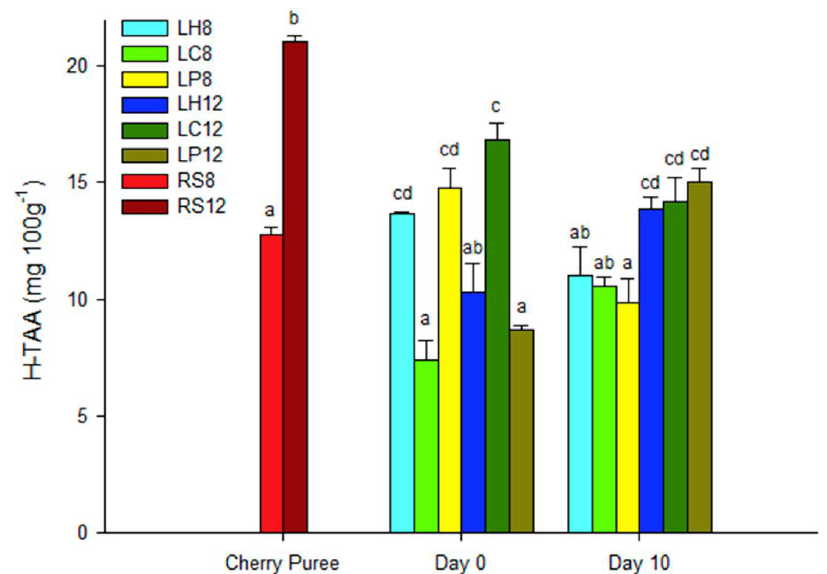
Figure 3. Total antioxidant activity due to hydrophilic compounds (H-TAA) (mg 100 g −1 ) of sweet